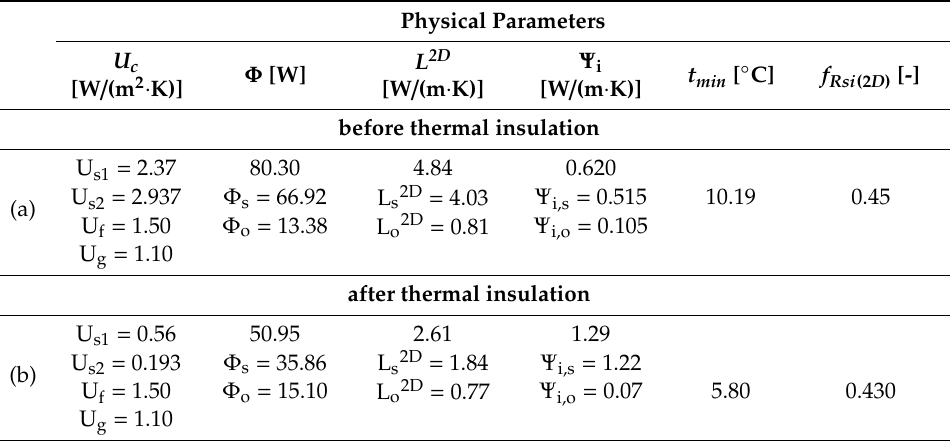
Table 9. Simulations involving physical parameters obtained by the simulation.